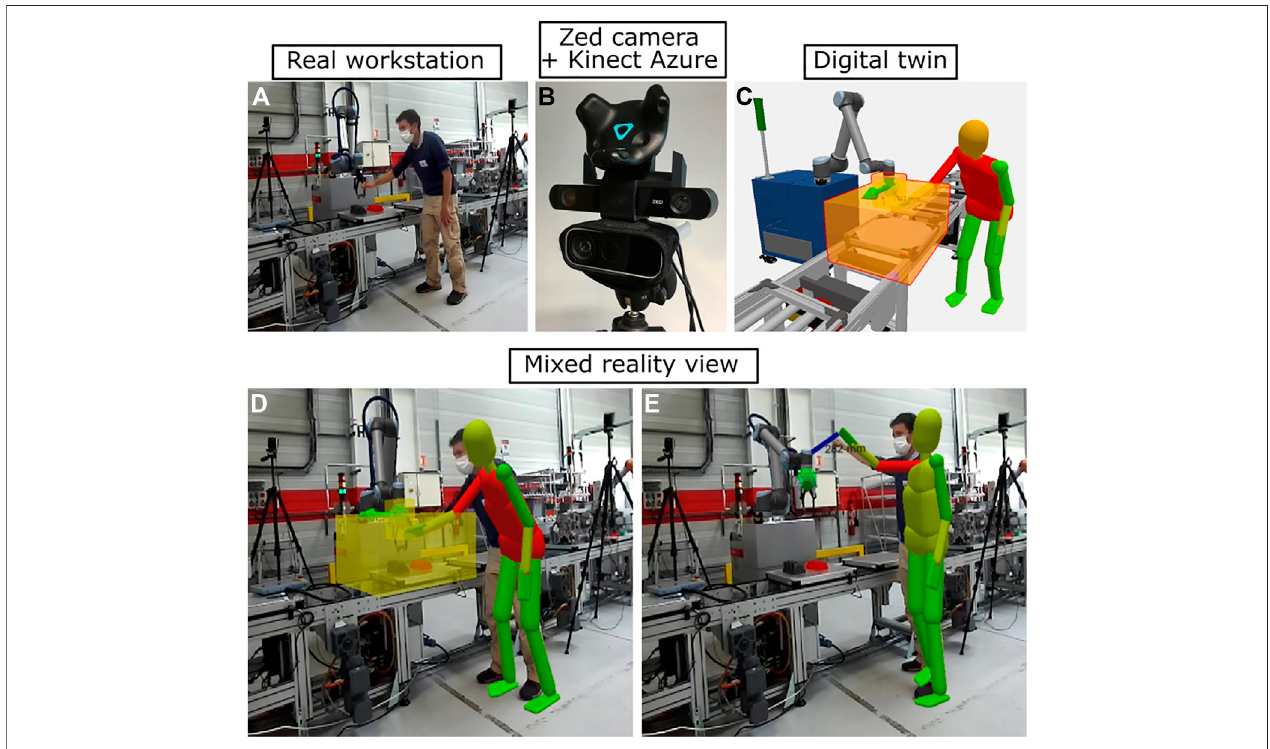
FIGURE 10 | A laboratory use case involving one UR10 robot. The real workstation (A) and the digital twin (C) are superimposed thanks to a Zed camera (B) to show the effector velocity, energy, safety areas, minimum distance to the operator and ergonomics scores (D, and E) . The operator ’ s posture is tracked thanks to a KinectAzurecamera fi xedtogetherwiththeZedcamera;theoffsetbetweentherealoperatorandthevirtualmanikinisduetoinaccuraciesinthemotiontrackingsystem and the cameras calibration.